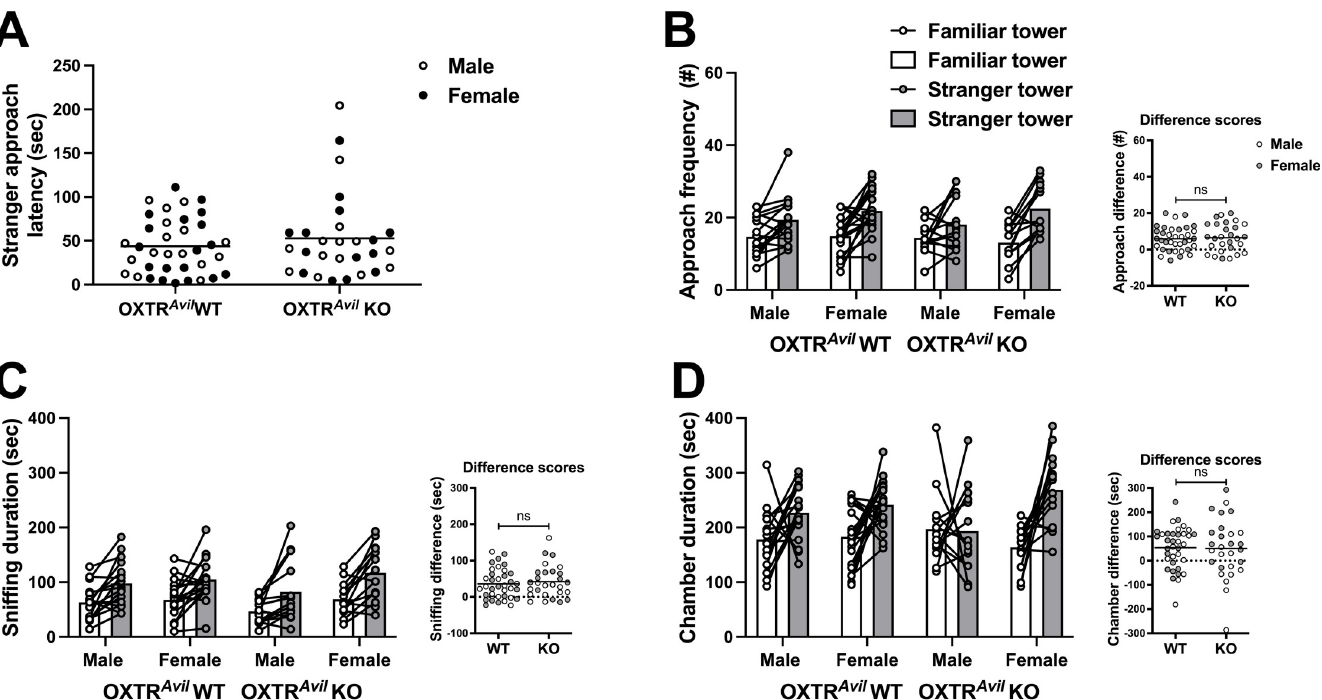
Fig 3. Preference for social novelty behaviors were similar in OXTR Avil WT and KO males and females. OXTR Avil mice displayed a preference for social novelty—a preference for a tower holding a novel stranger mouse (stranger tower; gray markers) over a tower holding a familiar mouse (familiar tower; white markers)—as evident by increased approach frequencies (B; F 1, 60 = 51.23, p < .001; d = 1.85) to the stranger tower, increased sniffing (C; F 1, 60 = 52.208, p < .001; d = 1.864), and chamber durations (D; F 1, 60 = 17.855, p < .001; d = 1.09). Social novelty preference was not impacted in OXTR Avil KO mice (no significant genotype x tower type interaction). Data are graphed as individual data points and group averages. Difference scores were calculated by subtracting approach frequency and sniffing/chamber duration towards the familiar conspecific from the stranger conspecific. ns = not significant. See also S3 Fig in S1 File, S1 Table in S1